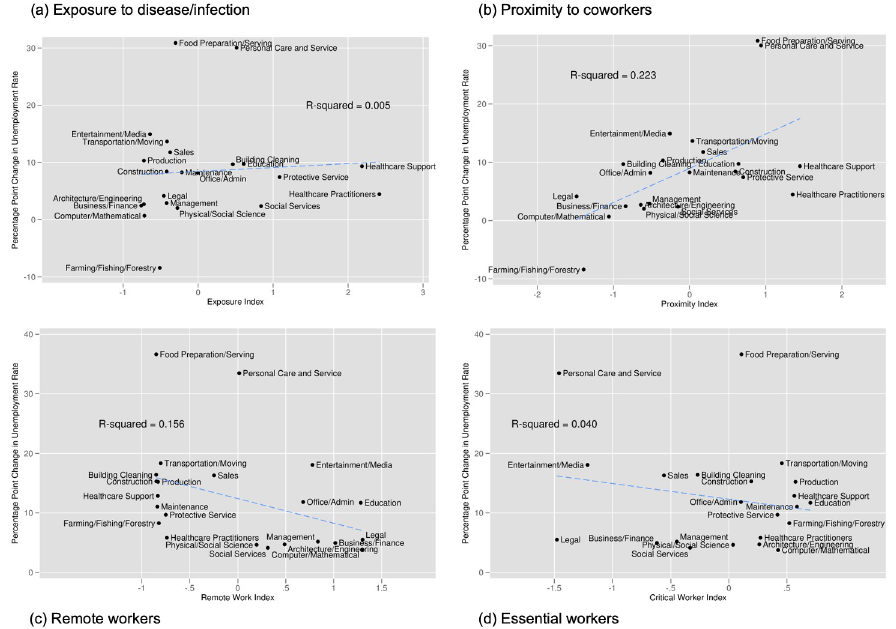
Fig 11. Percentage point change in unemployment (january 2020 to may 2020) by index and occupation. Notes: Unemployment data are from Current Population Survey, indexes are calculated by authors using data from O � NET, LMI, and [1]. The x-axis indicates the index value while the y-axis indicates the change in unemployment rate from January 2020 through May 2020. Each dot is a major occupation category (a two digit SOC code). Index values are normalized to mean 0 and standard deviation